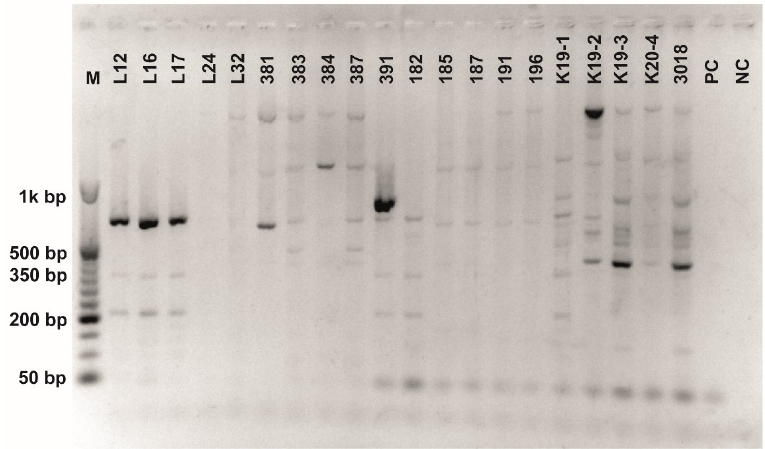
Figure A7. Class 2a bacteriocin gene belonging to the Clade 5 amplified using first primer pair (Table 3). O’RangeRuler TM 50 bp DNA Ladder was used as a molecular marker. PC-positive control by strain ATTCC 14917.